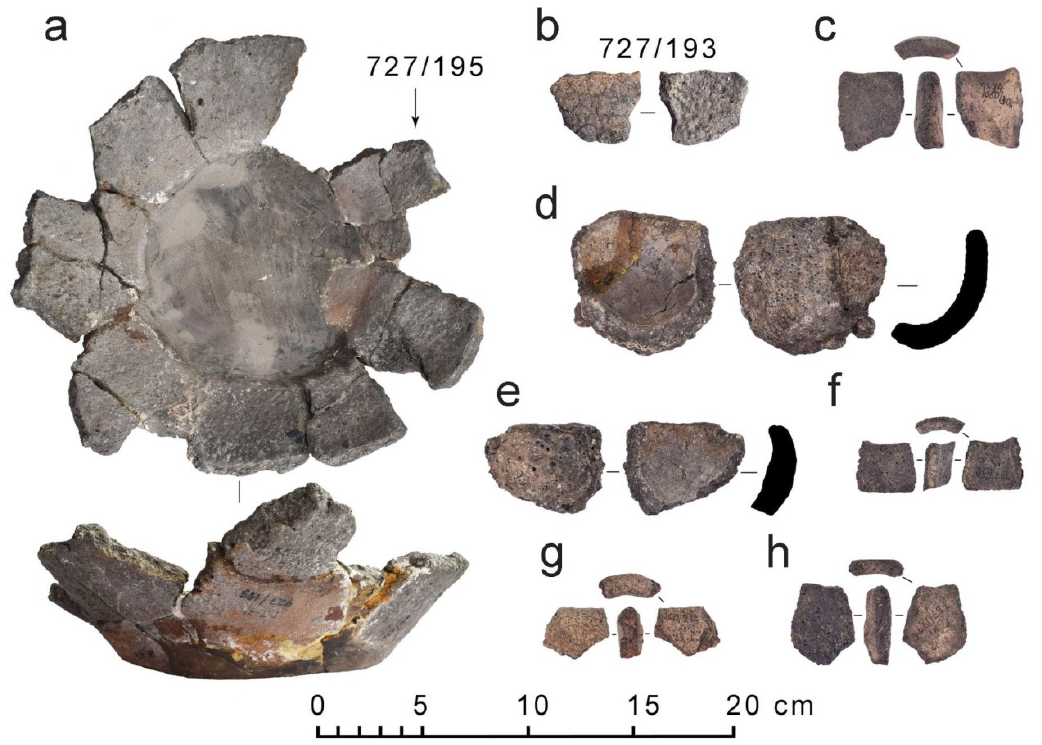
Figure 2. Crucibles from the Tiversk hillfort: ( a ) the rare crucible of large volume (plan and profile view); ( b ) separated sherd of the same crucible; ( c – h ) fragments of common crucibles for non-ferrous metal working.